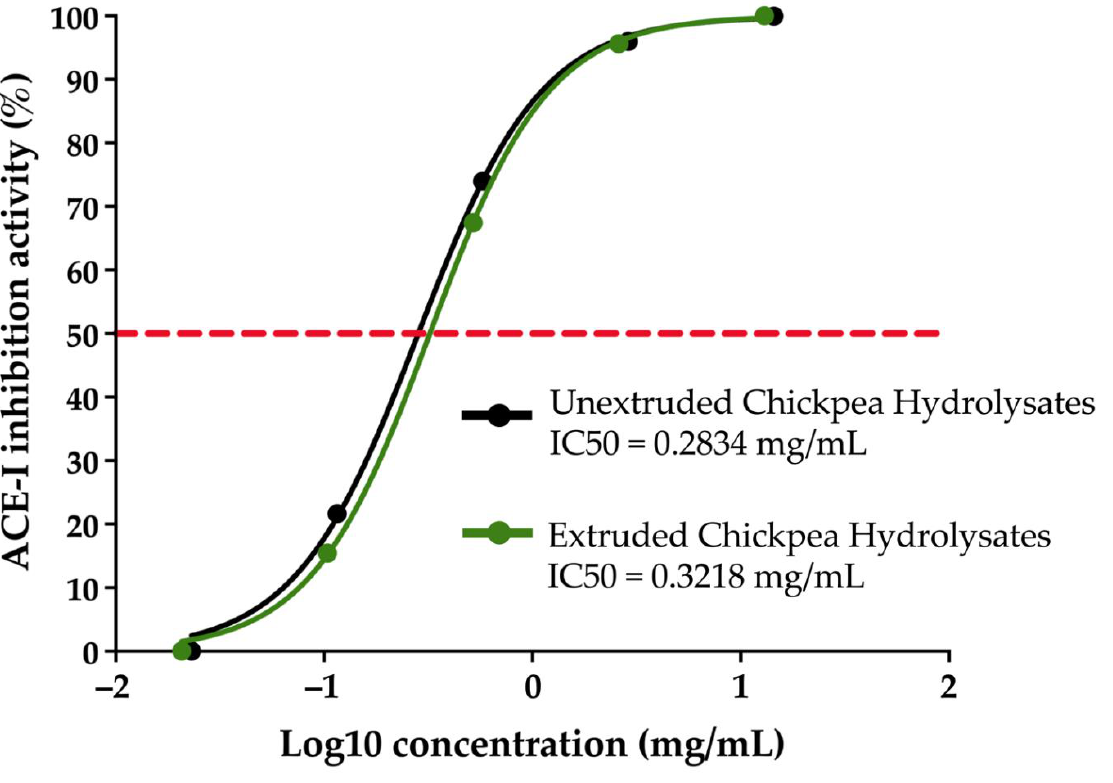
Figure 2. IC50 determination of chickpea hydrolysates. Extra-sum-of-squares F test of non-linear regression lines of IC50 estimations was employed to compare the two IC50 values